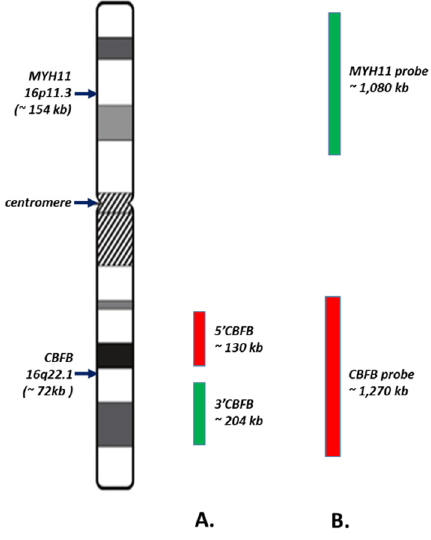
Figure 1. Schematic illustration of CBFB break-apart (BAP) and CBFB-MYH dual fusion (DF) FISH probe sets applied in this study. Information was obtained from the user’s guide provided by the manufacturers. ( A ) . CBFB BAP probe set with coverages of 5 ′ CBFB and flanking region (~ 130 kb) labeled with red dye, and 3 ′ CBFB and flanking region (~ 204 kb) labeled with green dye. ( B). CBFB-MYH11 DF probe set with coverages of CBFB and flanking region (~ 1270 kb) labeled with red dye, and MYH11 and flanking region (~ 1080 kb) labeled with green dye. The sizes are not to scale.